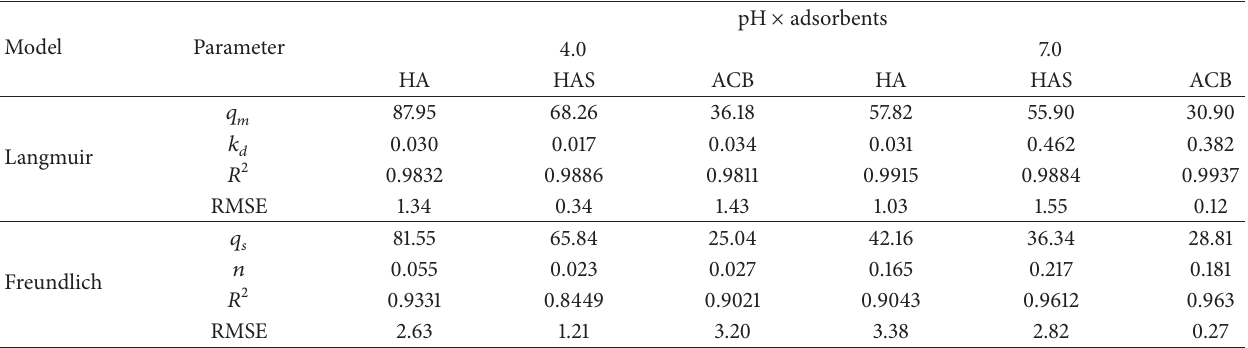
Table 3: Parameters of adsorption isotherms of bovine serum albumin on the adsorbent hydroxyapatite (HA), synthetic hydroxyapatite (HAS), and active babassu coal (ACB) at 25 ∘ C in pH 4.0 and pH 7.0 for the Langmuir and Freundlich models. pH × adsorbents Model Parameter HA HAS ACB HA HAS ACB 𝑞 𝑚 87.95 Langmuir 𝑞 Freundlich